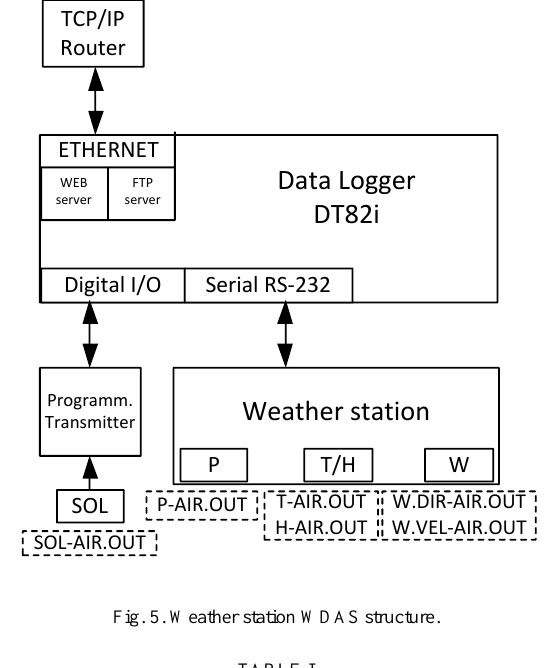
Fig. 5. Weather station WDAS structure.